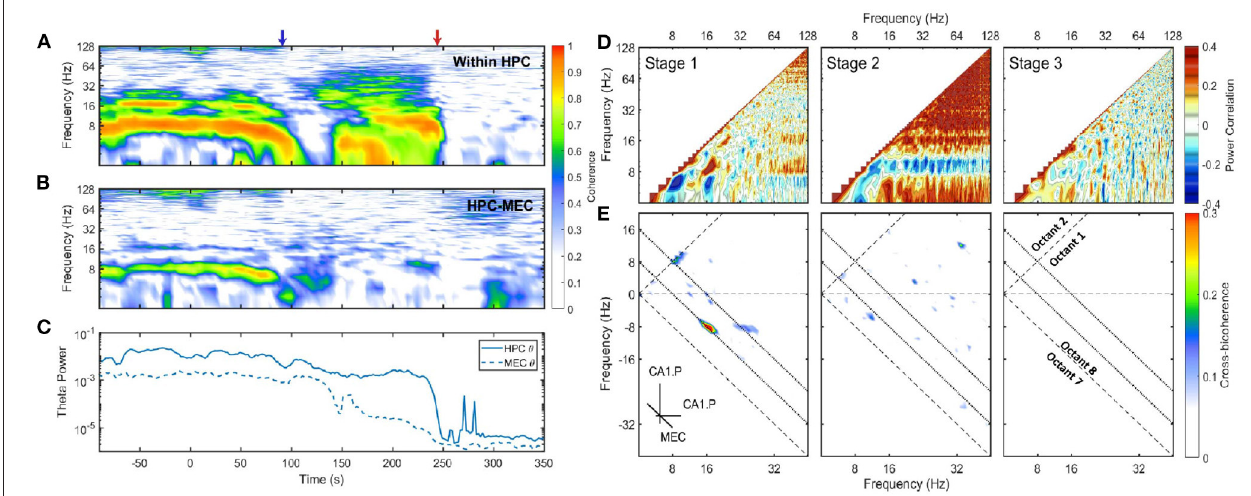
FIGURE 3 | (A) Coherence between CA1.Pyr and LM in HPC. The x-axis was the time and the y-axis was the frequency. Two transition periods were marked with blue and red arrows in the plot. Coherence is the modulus of the normalized cross-spectrum with a value between 0 and 1. High coherence indicates there is a consistent phase difference between two time series at that frequency. In terms of spectral analysis of LFP, high coherence within a narrow frequency band is a sign of the existence of oscillatory rhythm, and there is a phase difference either because the rhythm is a traveling wave or due to the bipolar nature of neurons. (B) The development of coherence between HPC and MEC. (C) The energy evolution of theta band in HPC and MEC, the variances were calculated with a window length of 10 s and a step increment of 2 s. (D) Average auto-correlation coefficients of Fourier transform estimated at three stages. As the auto-correlations are symmetric, only one half was presented. Positive correlation indicates the power of those two frequency components tend to grow or decay simultaneously, while negative correlation demonstrates that the power in some frequencies is lost as others increase (see Masimore et al., 2004, 2005). During stage 1, the positive correlation can be identified in three regions: The correlation between theta and theta harmonics represented by significant dots with frequency under 32 Hz; The correlation between gamma ( > 60 Hz) and theta (or theta harmonics) represented by horizontal strips. During stage 2, the power of 10 Hz frequency components was negatively correlated with other frequency components, while all other frequency components had positive power correlation. (E) Cross-bicoherence between HPC and MEC. Each point in the plot represented the cross-frequency coupling of the frequency triad (cid:0) f x , f y , f x + f y (cid:1) where f x and f y were frequency components in HPC and f x + f y was frequency component in MEC. Octant 1 and Octant 8 contained all the non-redundant information. Two inclined dotted lines indicated 8 and 16 Hz in MEC. During the stage 1, there were significant regions representing cross-region cross-frequency coupling of theta and its harmonics between HPC and MEC [ ( 8,8,16 ) Hz, ( 16, − 8,8 ) Hz and ( 24, − 8,16 ) Hz]. Data from